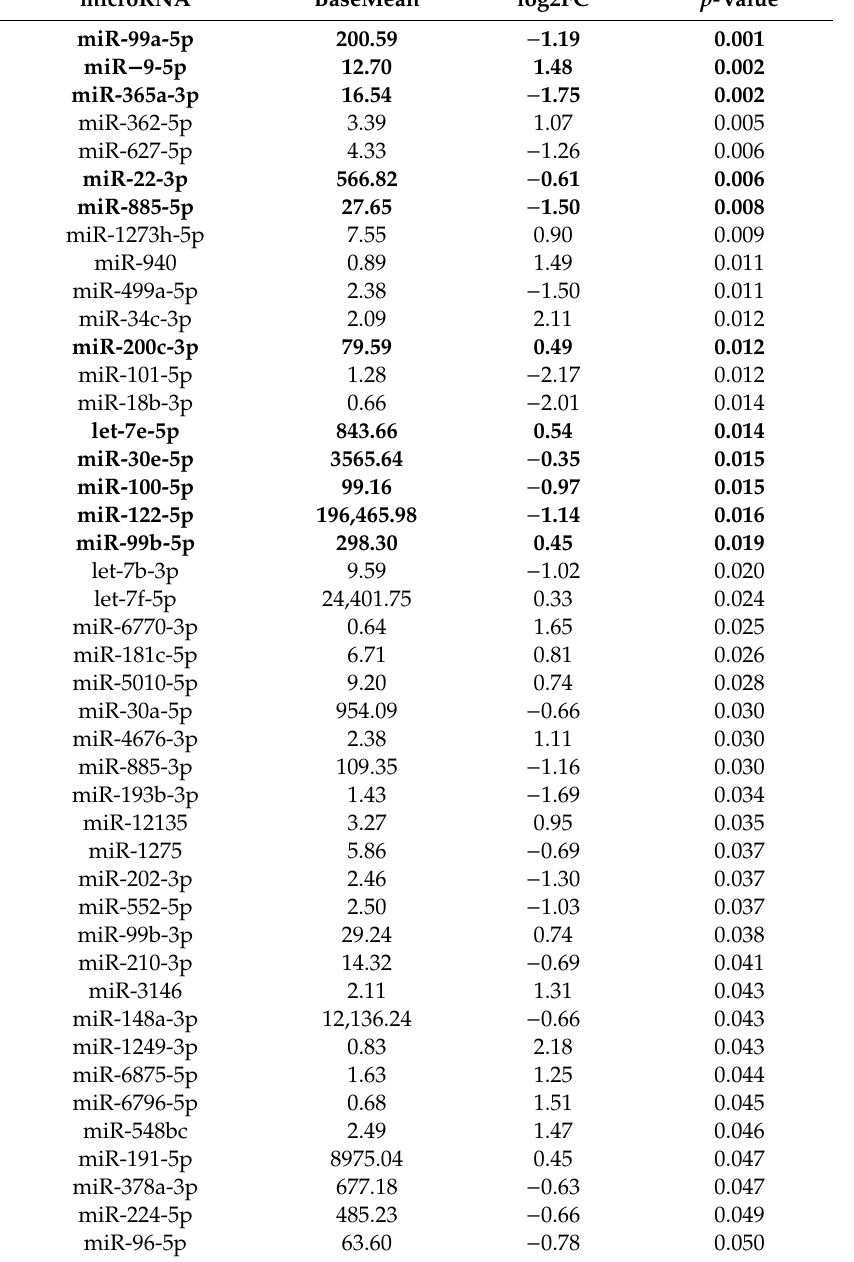
Table 2. List of the miRNAs with significantly di ff erent levels in blood plasma of patients with good (overall survival (OS) > 20 months) and poor prognosis (OS < 16 months) identified in the discovery phase of the